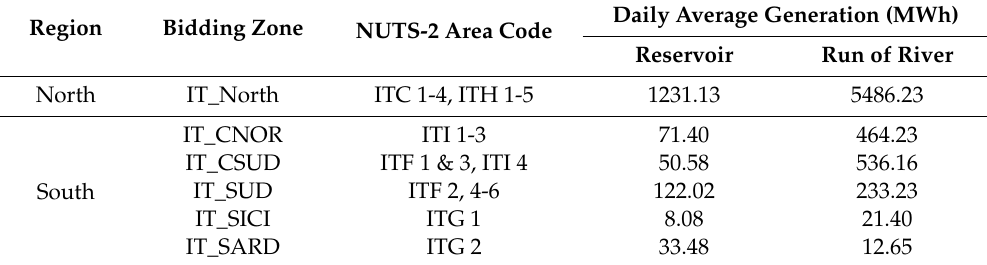
Table 5. Average hydro power generation for the six Italian bidding zones, as well as for North and South Italy for the period 2015–2019.